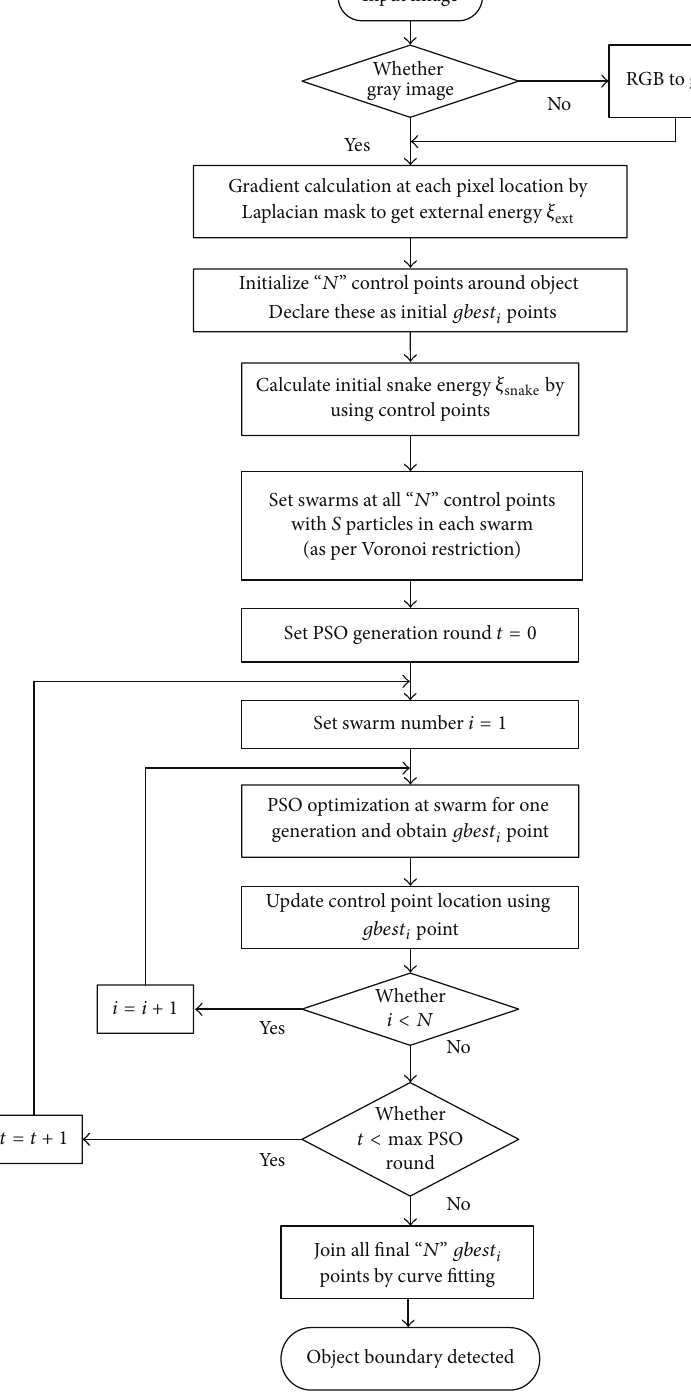
Figure 1: Flow chart of proposed multiswarm PSO-based active contour model.